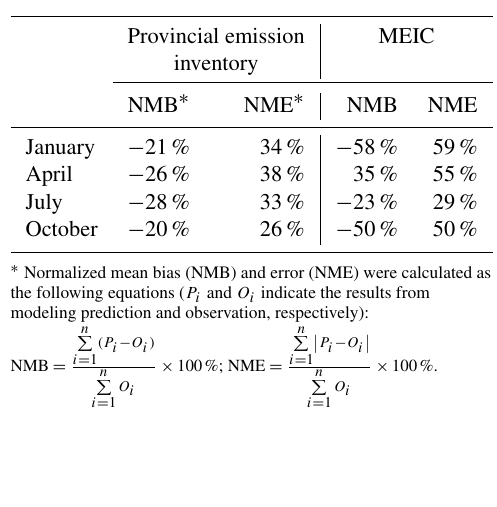
Table 6. Model performance of daily 1h maximum O 3 concentra- tions using MEIC and the provincial inventory for January, April, July and October 2012 in